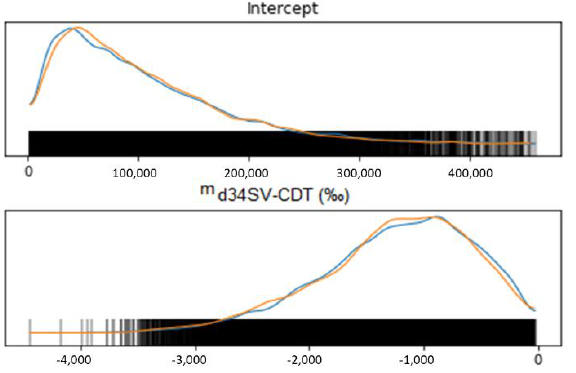
Figure 3. Posterior probability distributions of the proposed characterization model.